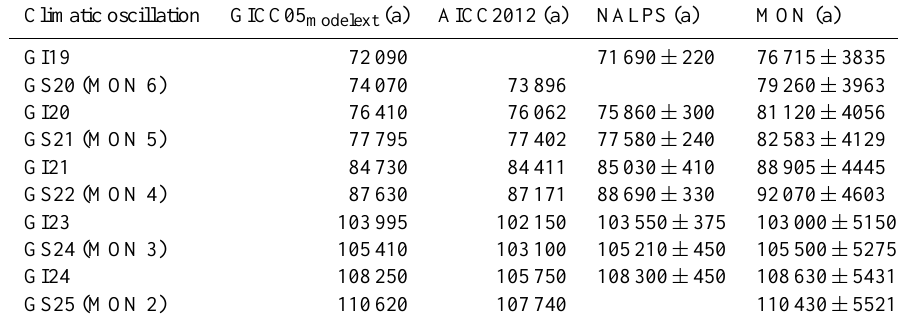
Table 3. Absolute dating of the millennial-scale climate transitions in the four different independent timescales from Greenland to the Mediterranean. NorthGRIP δ 18 O ice as constrained on GICC05 modelext chronology (Wolff et al., 2010) and AICC2012 timescale (Veres et al., 2013); NALPS composite speleothem δ 18 O record (Boch et al., 2011); and MON varve thickness record, including the ± 5% counting error (this